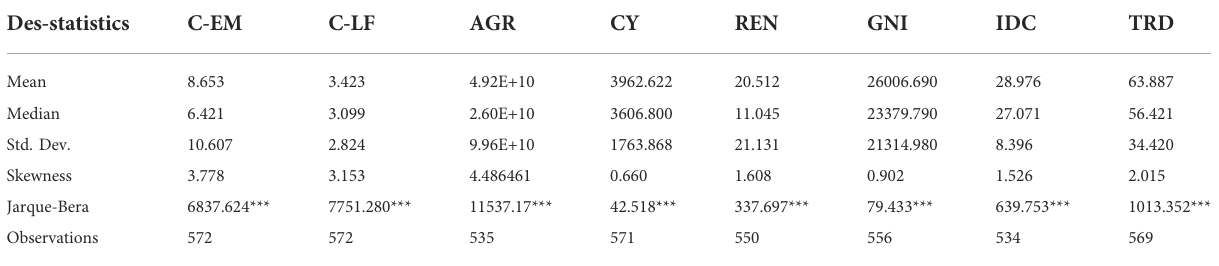
TABLE 2 Summary of descriptive statistics.